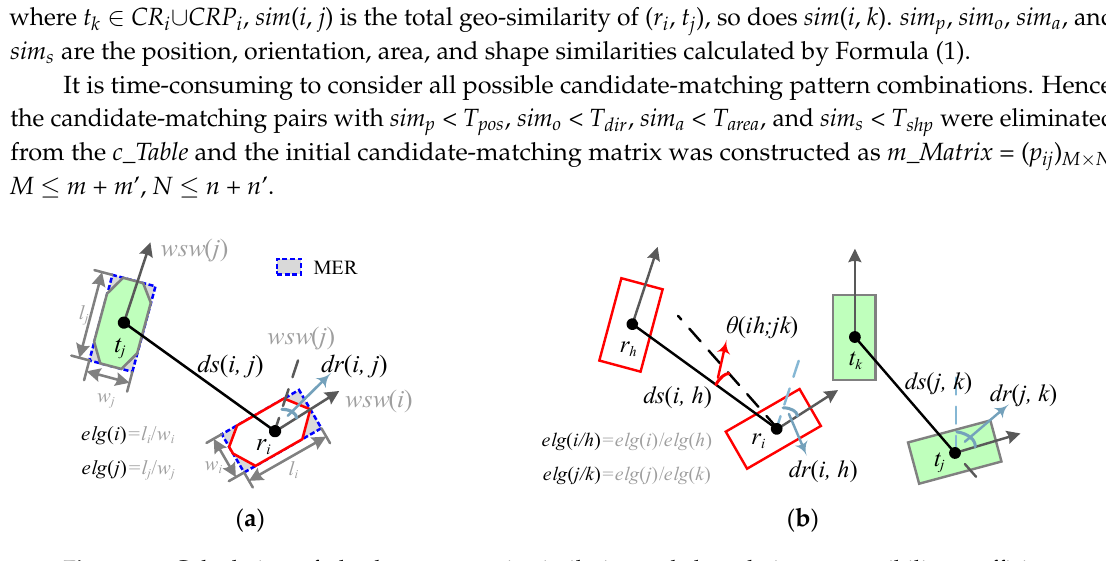
Figure 5. Calculation of absolute geometric similarity and the relative compatibility coefficient: ( a ) absolute geometric similarity between candidate ‐ matching pairs; ( b ) relative compatibility coefficient between neighboring candidate ‐ matching pairs. MER: minimum enclosing rectangle.